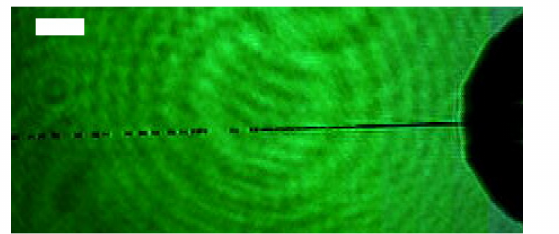
Figure 1. The Rayleigh breakup point can be seen where the stable liquid jet forms discrete droplets. The Rayleigh breakup length, or jet length, for a given solution is related to the jet diameter and the jet speed. Scale bar: 100 µm. Figure originally published in Opt. Express